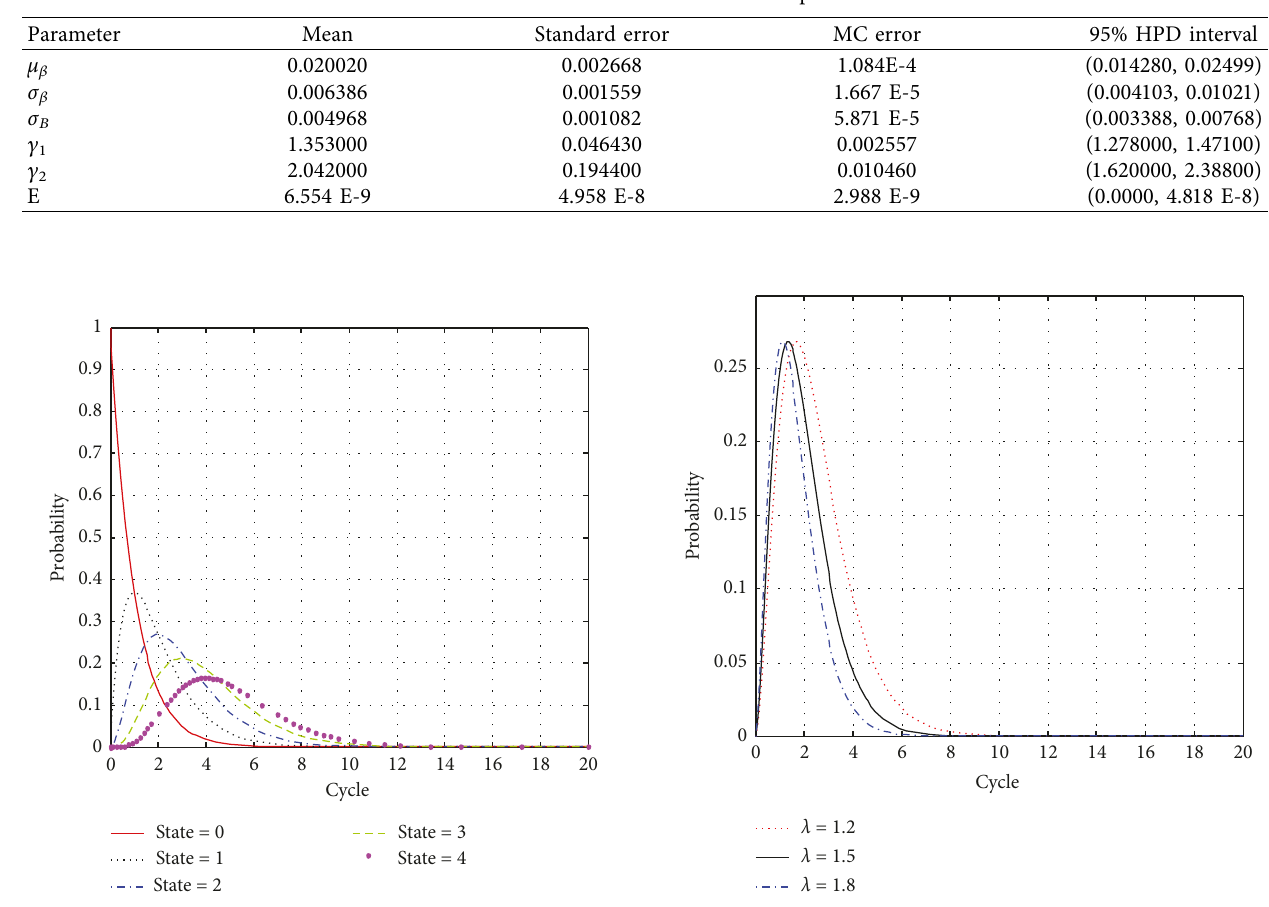
Figure 4: Probability curves in different states. Figure 5: Sensitivity analysis of state 2 on λ